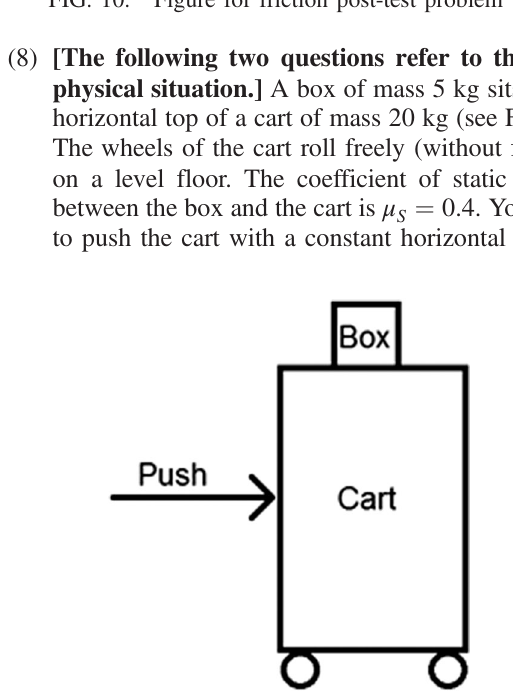
FIG. 11. Figure for friction post-test problems 8 –